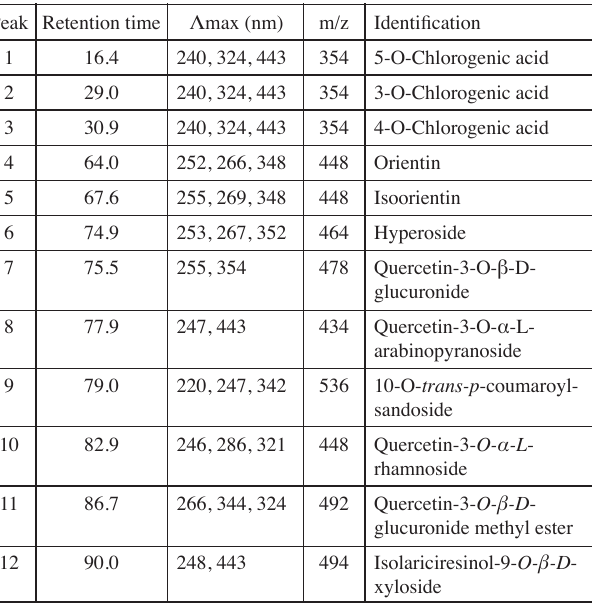
Tab. 1: Identification of 12 compounds.